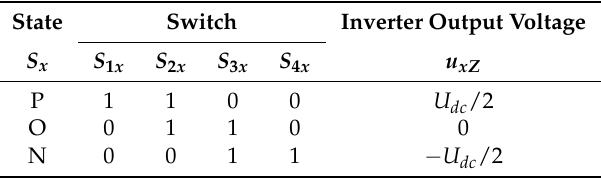
Table 1. Operating status of inverter leg x ∈ { a , b , c }